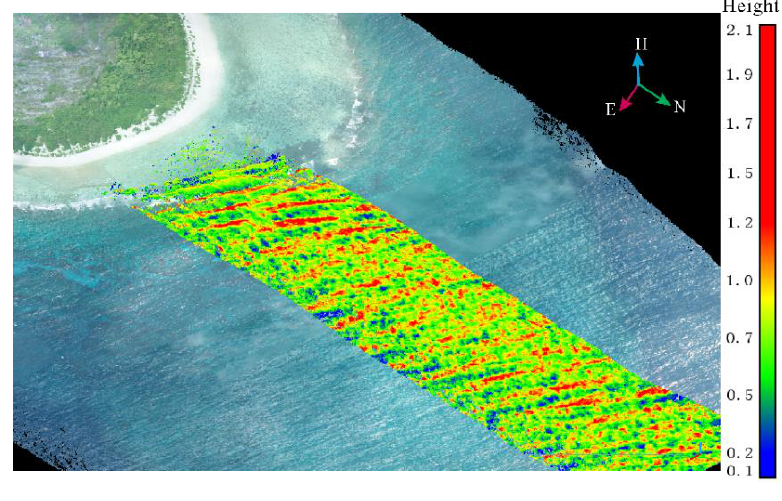
Figure 11. The surface point cloud reflects the ocean state of the two experimental areas. To facilitate the visualization of the distribution, a Weibull function was used to fit each probability distribution of the incident angle correction value. It can be clearly seen that the correction effect of the laser incident angle is different under different normal vector estimation